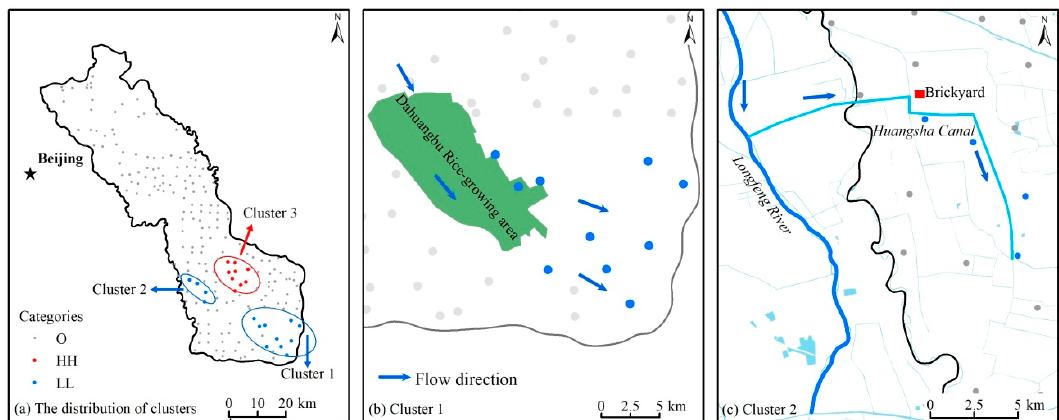
Figure 4. ( a ) Distribution of clusters from the cluster analysis (CA). Surrounding environment of ( b ) Cluster 1 and ( c ) Cluster 2 are also shown.